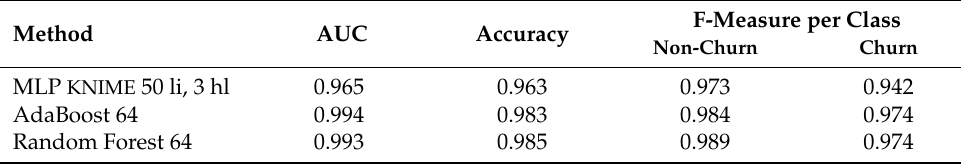
Table 3. Models’ performance on the testing set (using training set